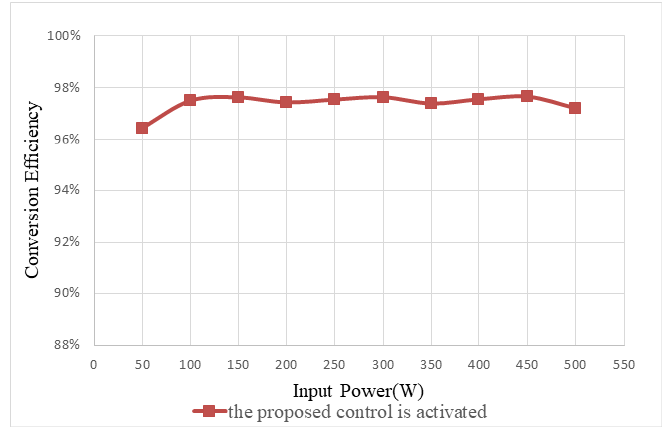
Figure 17. Measured results are compared with proposed method under different loads.